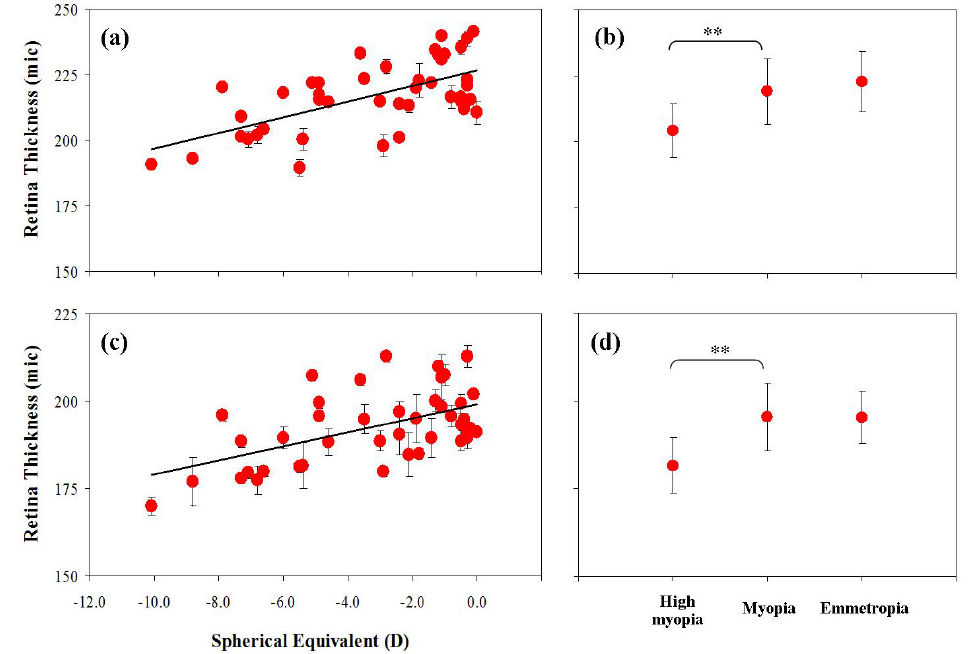
Figure 8. Retinal thickness at locations T1 ( a ) and T2 ( c ) as a function of the SE for every patient. ( b , d ) Averaged retinal thickness values for the three groups of patients: location T1 ( b ); location T2 ( d ). In panels ( b , d ) **: p < 0.004. Error bars indicate the standard deviation in all panels. For some data in left panel, the size of the error bars are within the red symbols.